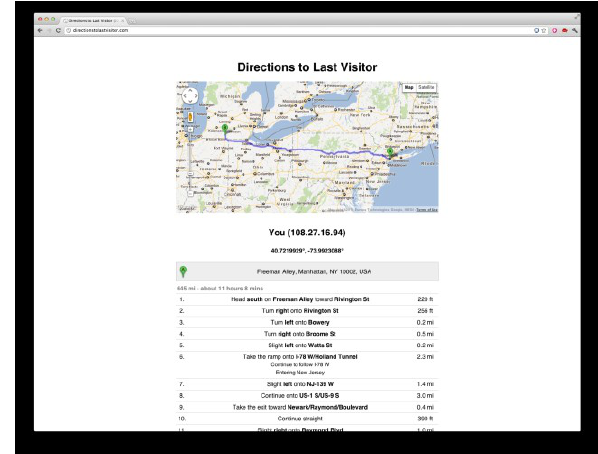
Figure 3 | Vito Acconci, Theme Song (1973). Still image. Courtesy of the artist.